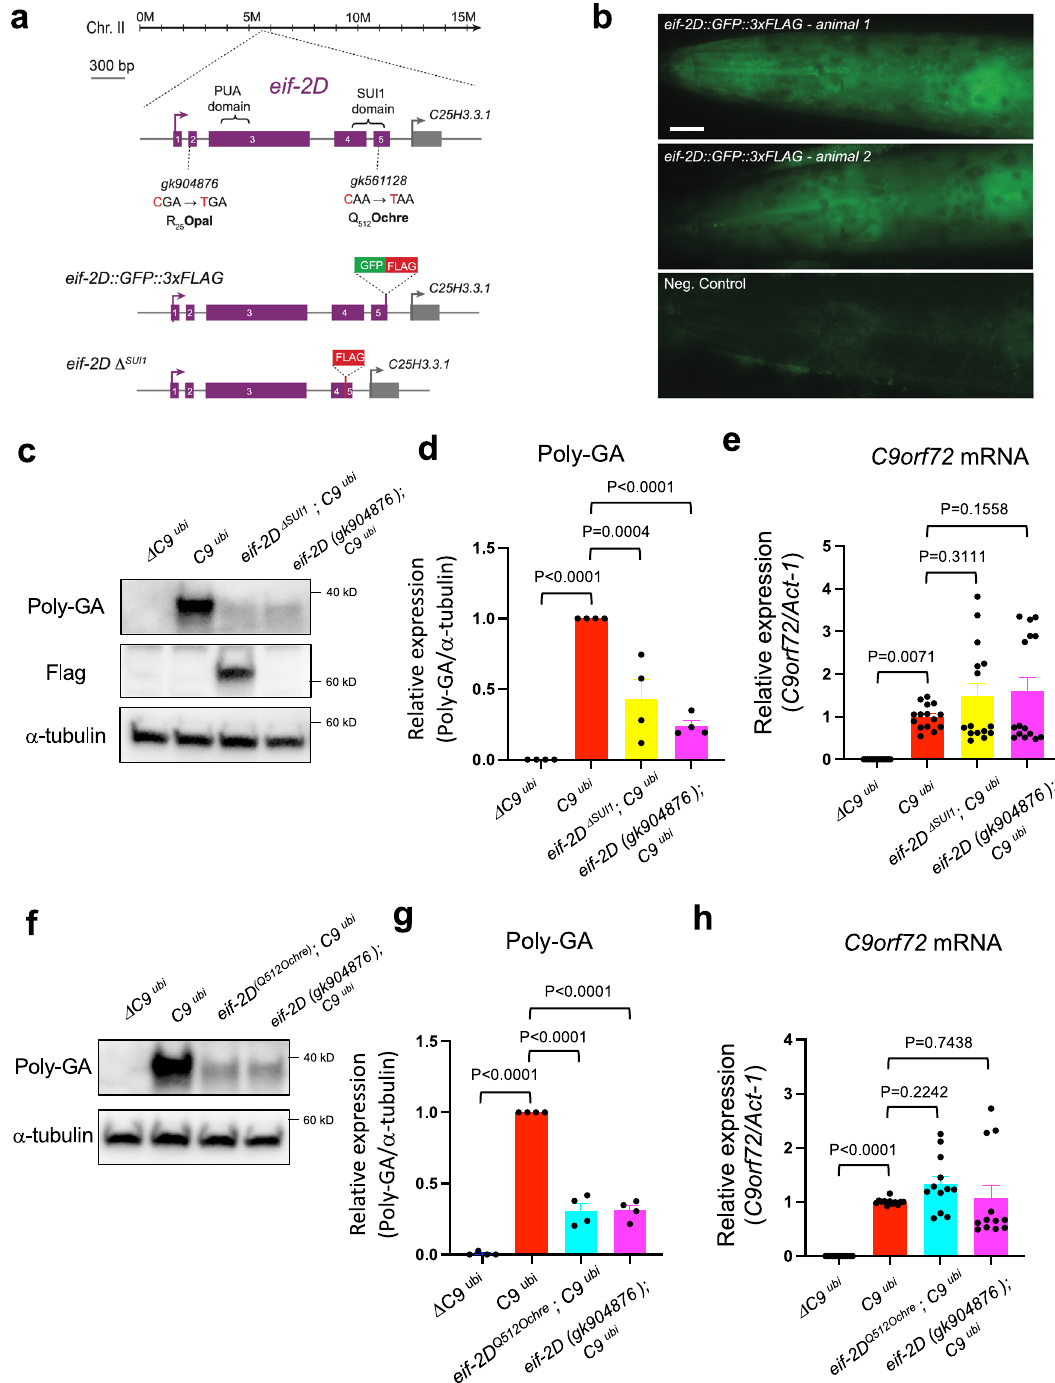
Fig. 5 The SUI1 domain of eIF-2D is required for poly-GA production. a Schematic of the eif-2D genetic locus. Missense mutations ( gk904876 , gk561128) and CRISPR/Cas9-engineered alleles (syb3364[eif-2D::GFP::3xFLAG] , syb3432[eif-2D Δ SUI1 ]) are shown. The PUA and SUI1 domain are indicated with brackets. b An endogenous reporter allele ( syb3364 ) shows cytoplasmic eif-2D expression. Dark oval or circular shapes of various sizes are nuclei of different cell types. Representative images of the head of two animals (L4 stage) are shown. Negative control is a wild-type (N2) animal (L4). Scale bar = 10 μ m. c , f Worm lysates were processed for western blotting and immunostained with poly-GA and α -tubulin antibodies. d , g Quanti fi cation of poly-GA expression on western blots. The experiments were repeated four times. Mean ± s.e.m. One-way ANOVA with Dunnett ’ s multiple comparisons test was performed. e , h The G4C2 repeat RNA with C9orf72 intronic RNA, and act-1 mRNAs were assessed by RT-PCR. The experiments were repeated four times in e and fi ve times in h . Mean ± s.e.m. One-way ANOVA with Dunnett ’ s multiple comparisons test was